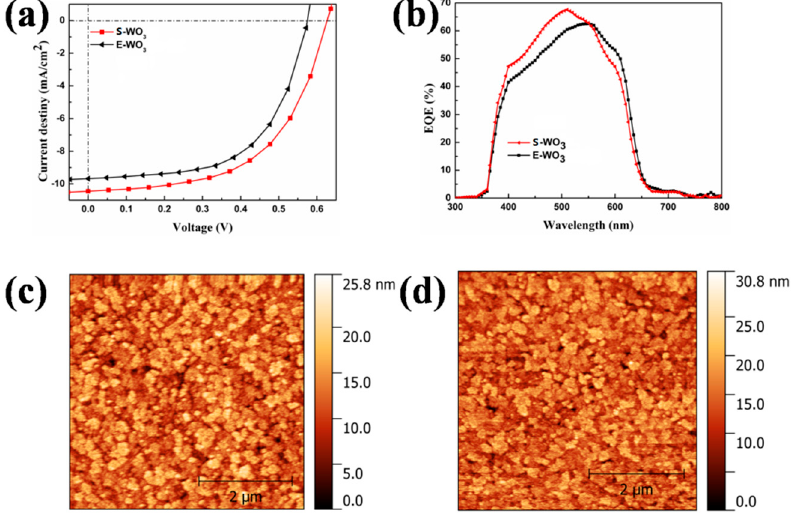
Figure 4. ( a ) Current density versus voltage ( J–V ) characteristics of OSCs with S-WO 3 and E-WO 3 films; ( b ) external quantum efficiency ( EQE ) characteristics of OSCs with S-WO 3 and E-WO 3 films; Atomic force microscopy (AFM) images of ( c ) S-WO 3 ; ( d ) E-WO 3 . Table 1. Comparison of device characteristics of OSCs based on E-WO 3 and S-WO 3 films with different precursor concentrations.